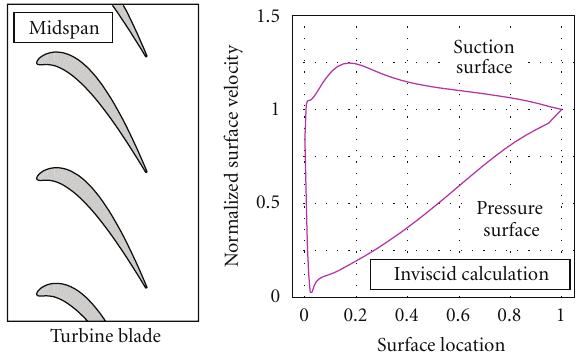
Figure 3: Corresponding turbine rotor.